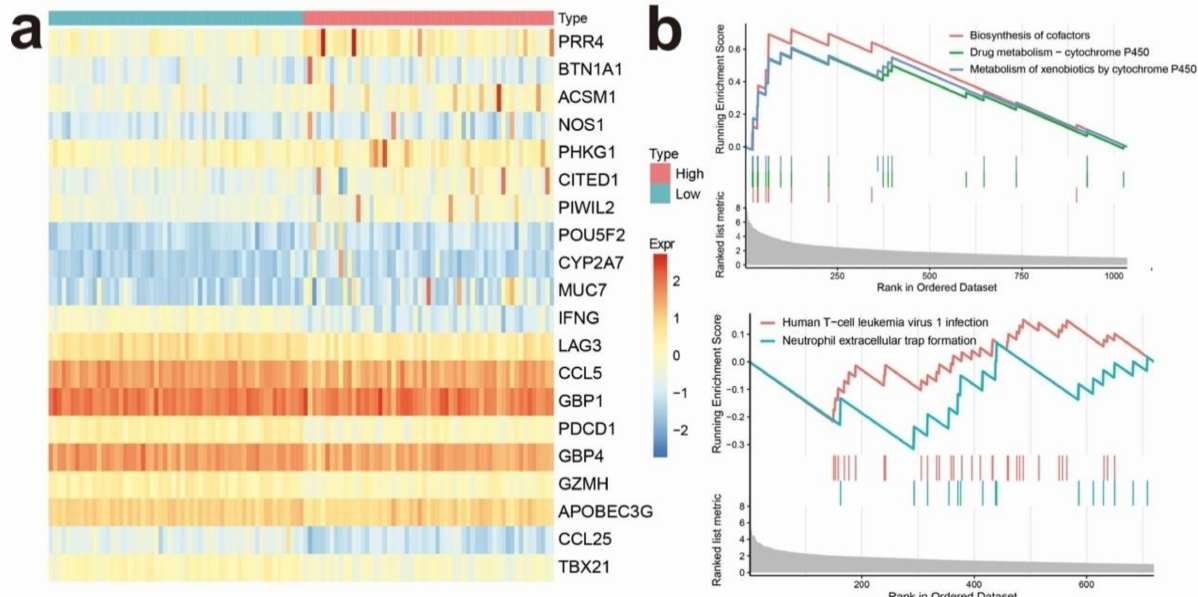
Figure 4. Identifying differentially expressed genes (DEGs) in different IRGPI subgroups. ( a ) Heat map of DEGs between high and low IRGPI risk groups; ( b ) significantly enriched pathways of upregulated DEGs in the high (above) and low (below) IRGPI risk groups revealed by